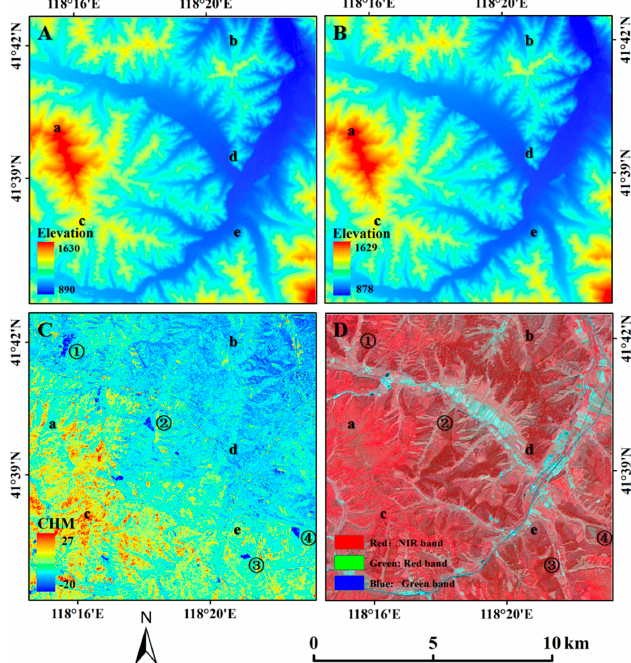
Figure 3. A comparison of the digital surface model (DSM) images from leaf-on season ( A ) and leaf-off season ( B ). The difference between DSMs was used to produce a relative canopy height (RCH) image, especially for a deciduous forest ( C ). As a comparison with the RCH image, a color composite ( D ) using the ZiYuan-3 multispectral image at the leaf-on season at the same site was provided (a: birch, b: Mongolia scotch pine, c: other broadleaf, d: Chinese pine, and e: larch). The blue color in locations ①, ②, ③, and ④ indicates deforestation sites of plantations between 2015 and 2017.